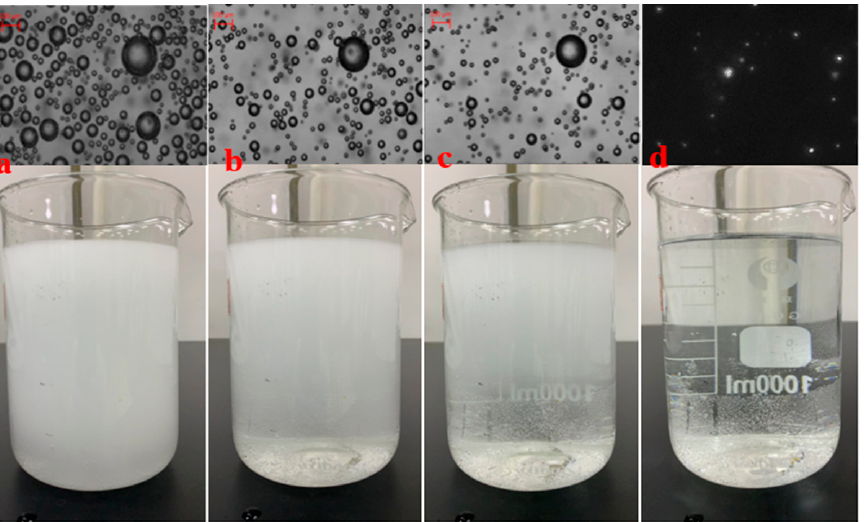
Table 1. Variation of number of micro-bubbles with ageing time (when the preparation time=2 min, and aeration rate=0.5 L/min).